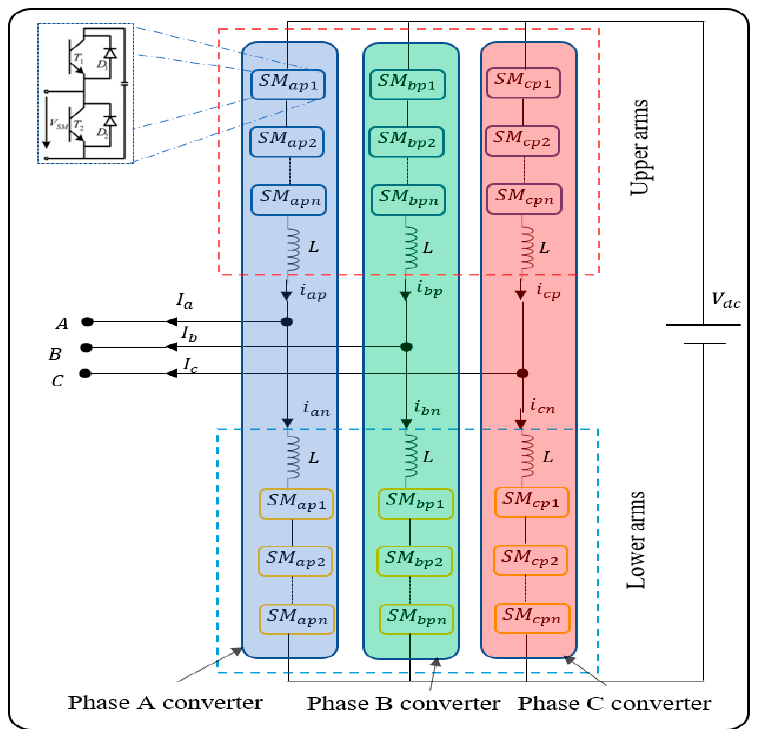
Figure 1. Structure of a three-phase MMC with half-bridge submodules [6]. Most voltage-source converters (VSCs) use IGBTs as the power devices because